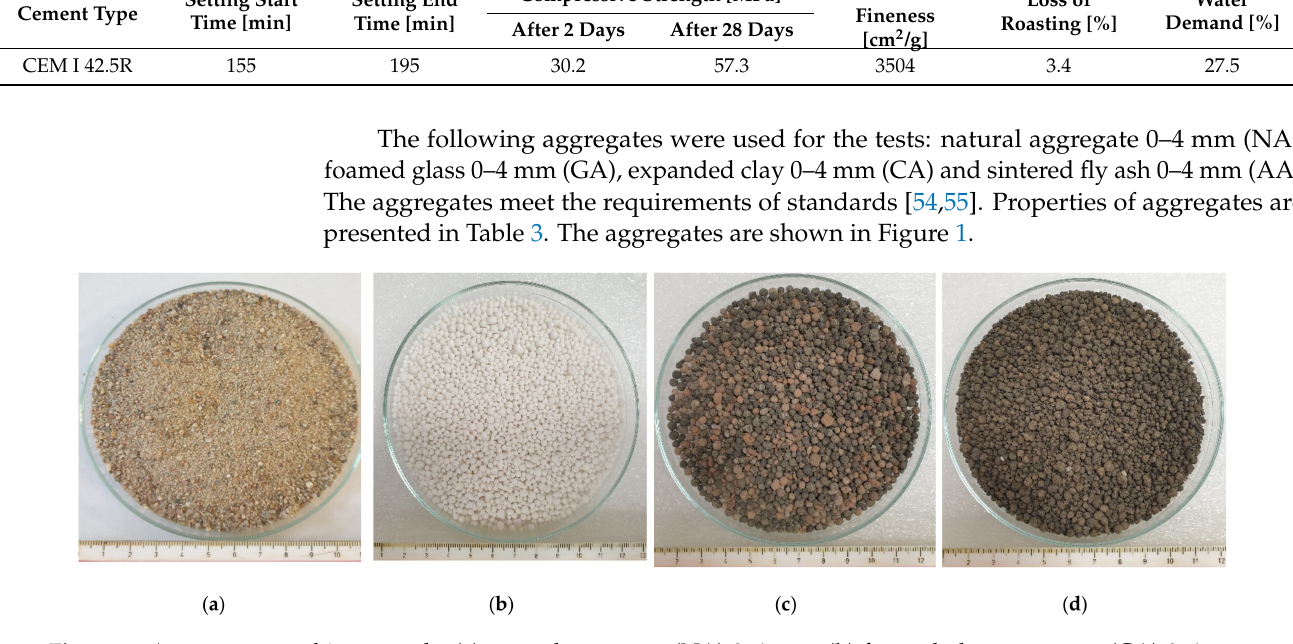
Figure 1. Aggregates used in research. ( a ) natural aggregate (NA) 0–4 mm; ( b ) foamed glass aggregate (GA) 0–4 mm; ( c ) expanded clay aggregate (CA) 0–4 mm; ( d ) granulated fly ash aggregate (AA) 0–4